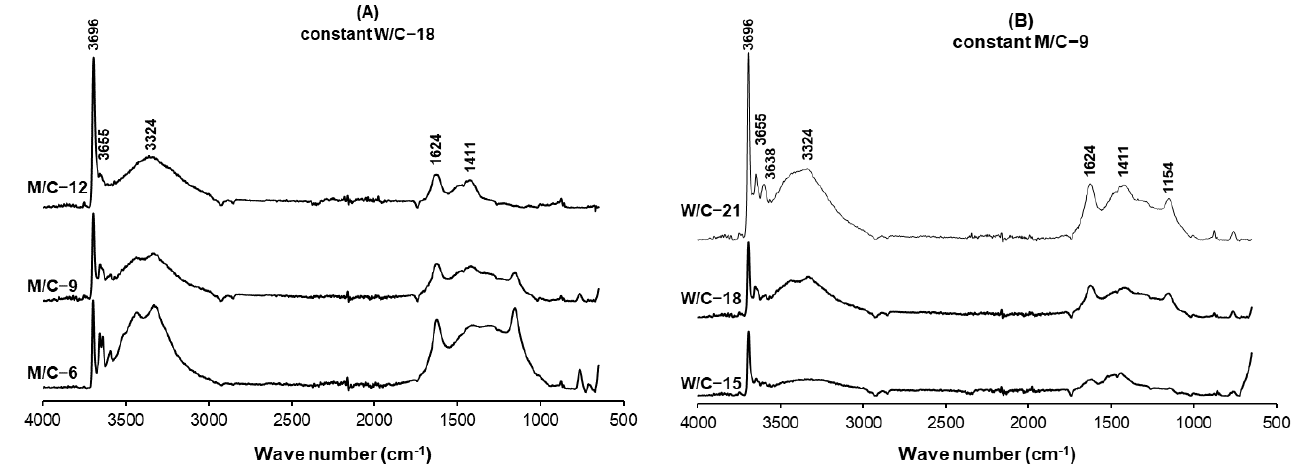
Figure 3. The ATR-FTIR curves of the MOC binders with different molar ratios, ( A ) different MgO:MgCl 2 ratio, ( B ) different H 2 O:MgCl 2 ratio.